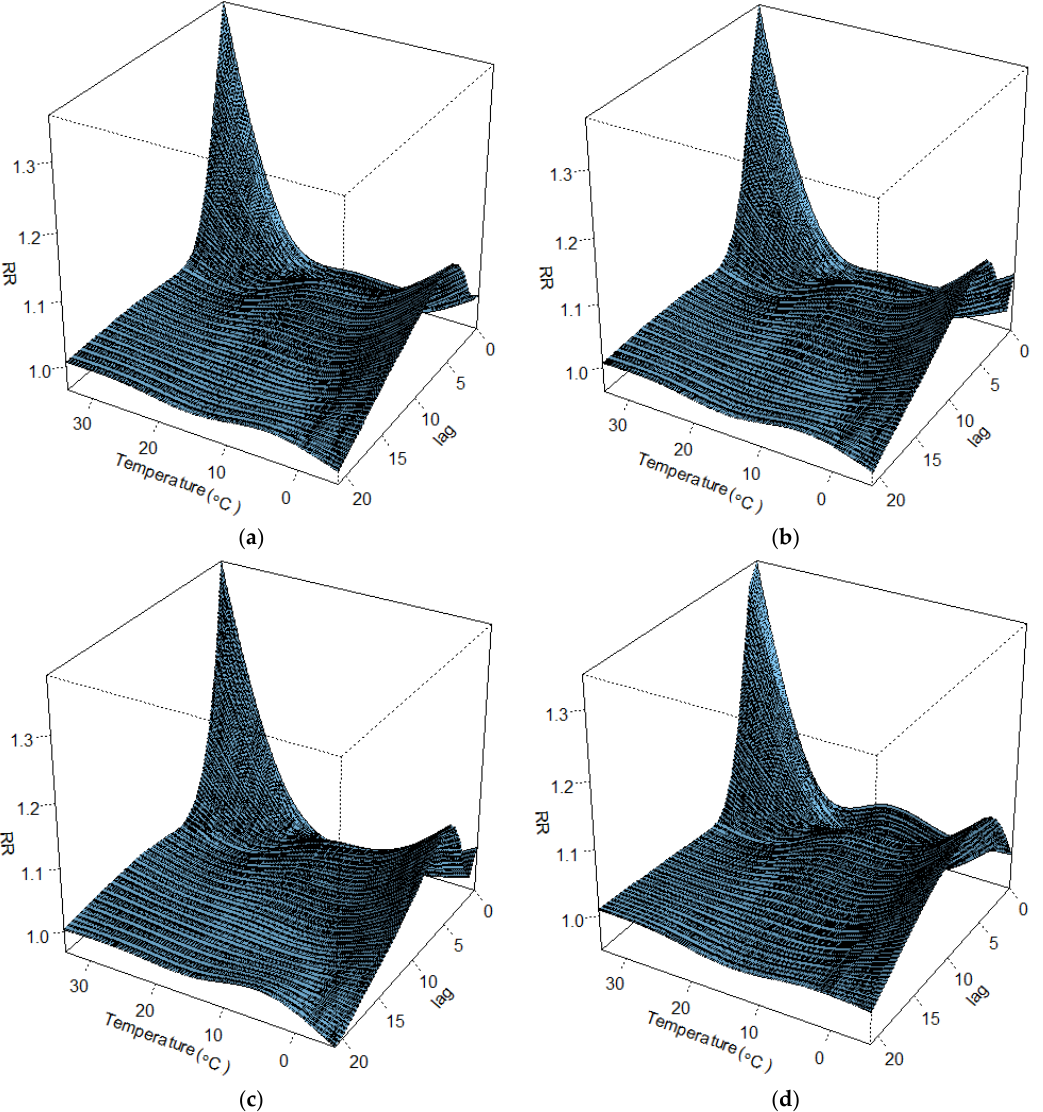
Figure 2. 3D plots of the non-linear relationship between mean temperature and cardiorespiratory mortality in EMT between 1999 and 2018 for ( a ) the total population, ( b ) the elderly, ( c ) males, and ( d ) females.